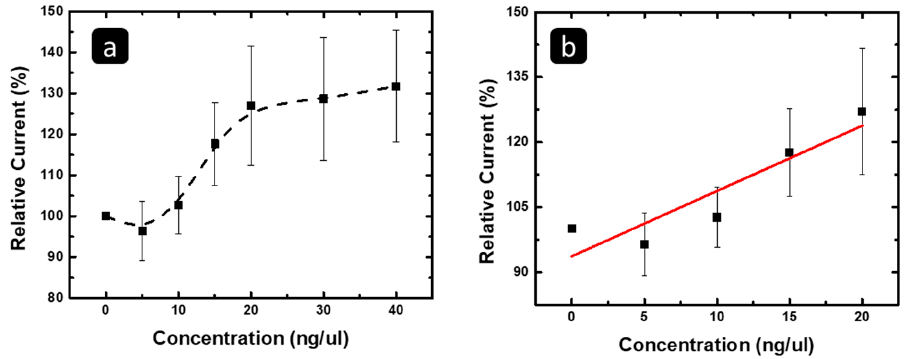
Figure 7. The correlation between the relative increase of the SWV peak current versus the concen- tration of the MCF 7 exosomal RNA with the concentration range of ( a ) 0–40 and ( b ) 0–20 ng/µL.